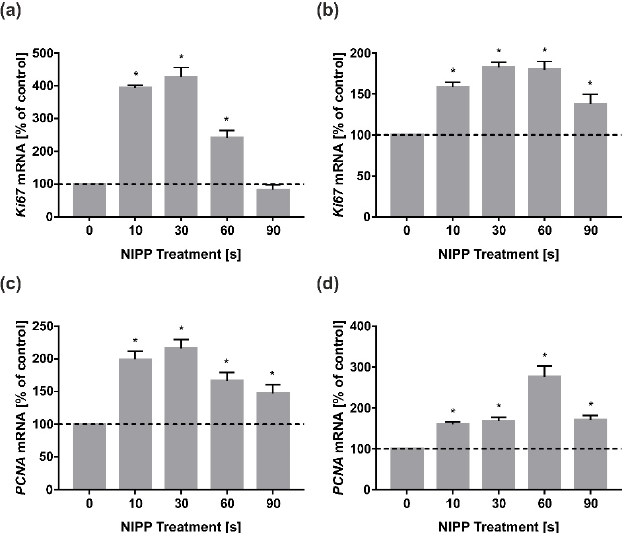
Figure 1. Influence of NIPP on Ki67 and PCNA mRNA levels in HGF and HGK at 24 h. Treatment was performed for the indicated times: ( a ) Ki67 mRNA in HGF; ( b ) Ki67 mRNA in HGK; ( c ) PCNA mRNA in HGF; ( d ) PCNA mRNA in HGK. n = 9. * statistical significance compared to control (0 s) ( p < 0.05).